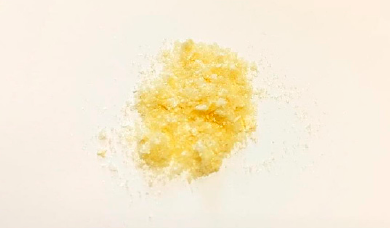
Figure 1. Procedure for the preparation of dry phenolic extracts from seeds.